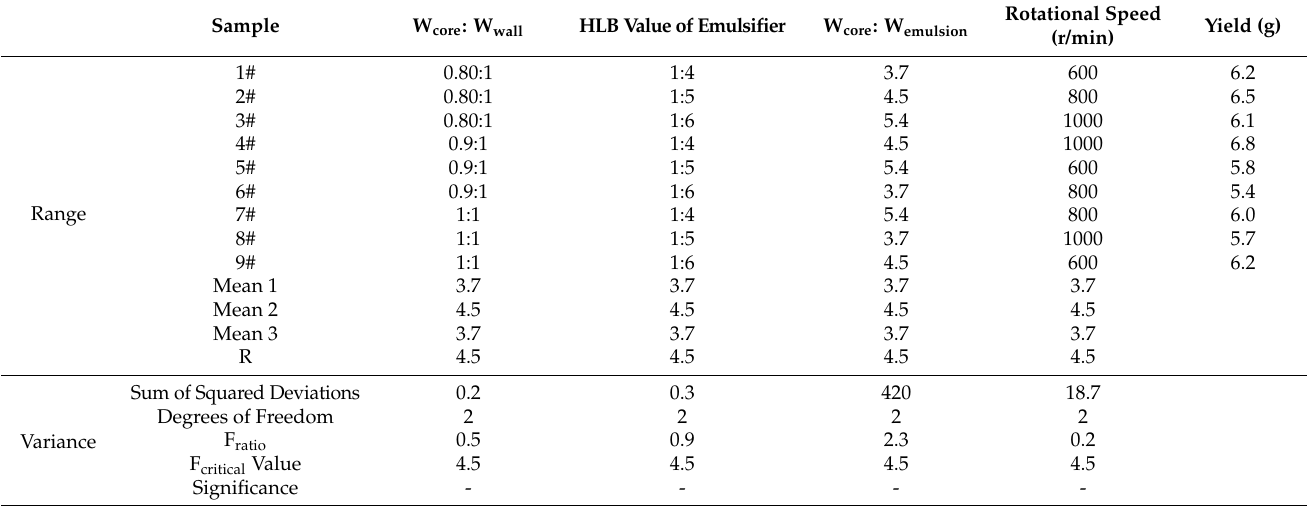
Table 6. Orthogonal experiment results for